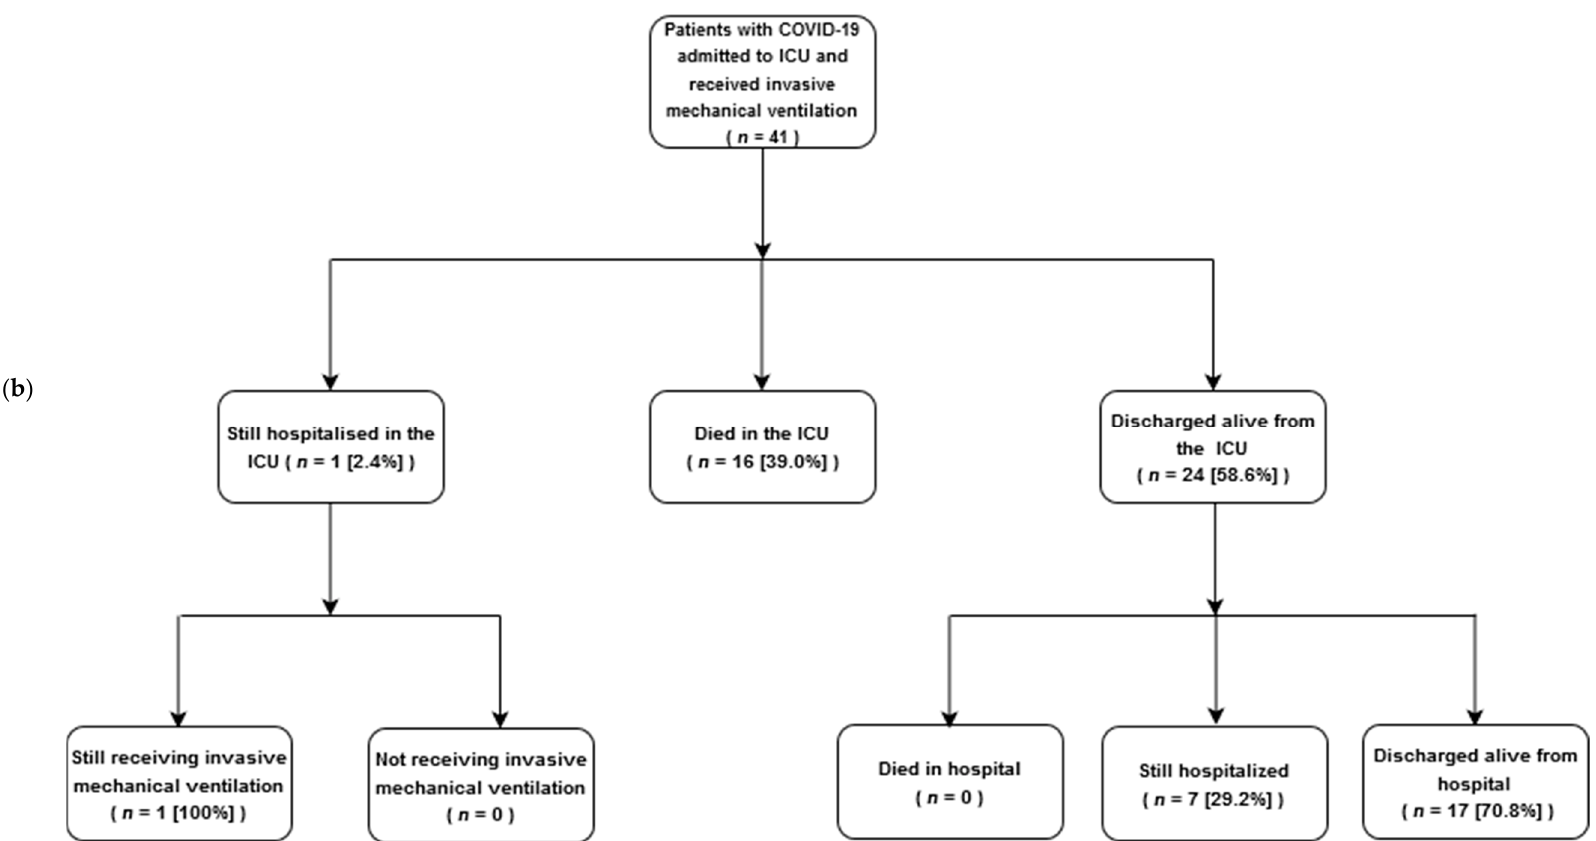
Figure 1. Flow diagram for study patients who were admitted to COVID-19 designated ICUs ( a ), and received invasive mechanical ventilation ( b ). Abbreviations: COVID-19 = coronavirus disease 2019, ICU = intensive care unit.